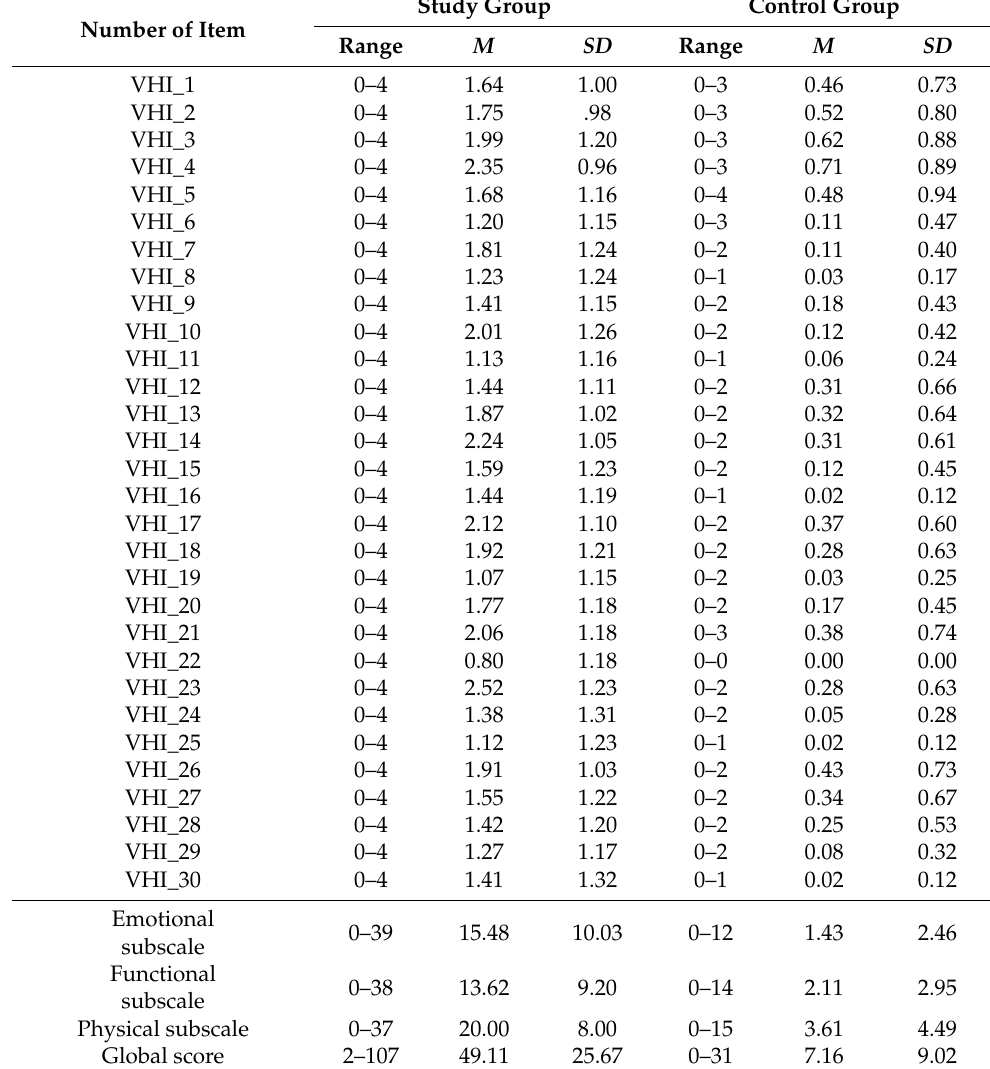
Table 1. Descriptive statistics for VHI